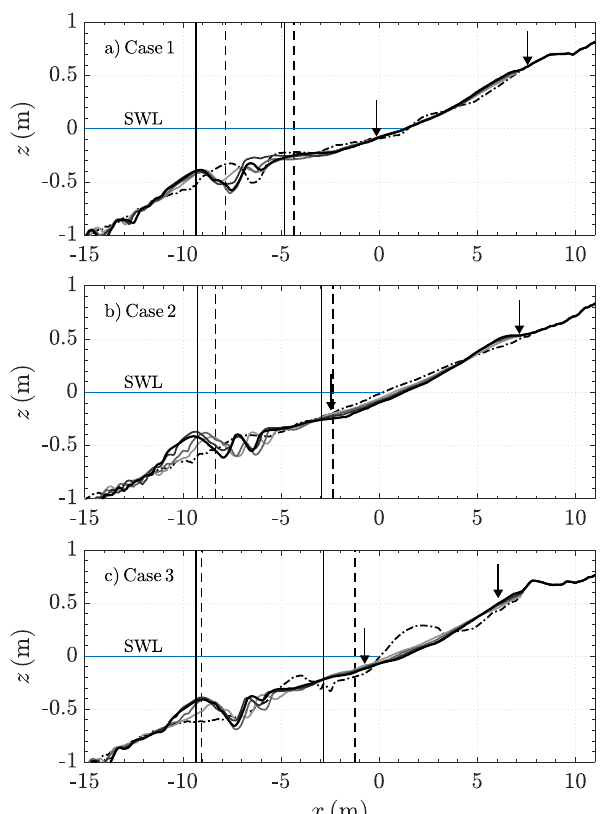
Figure 3. Beach profile evolution in 30min time intervals. Colour changes from light to dark as time progresses. The dashed-dotted line presents the initial beach profile. Vertical dashed (solid) lines indicate the outer and inner breaking locations taken from observations during the first (last) 30min run. Arrows indicate the rundown and runup limit during the first 30min run. ( a ) Case1; ( b ) Case2; ( c ) Case3.